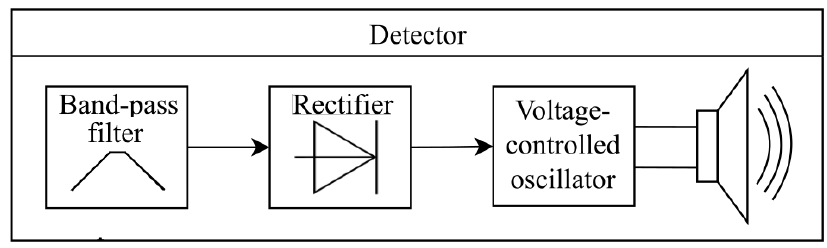
Figure 6. Scheme of the analog Duffing oscillator mode